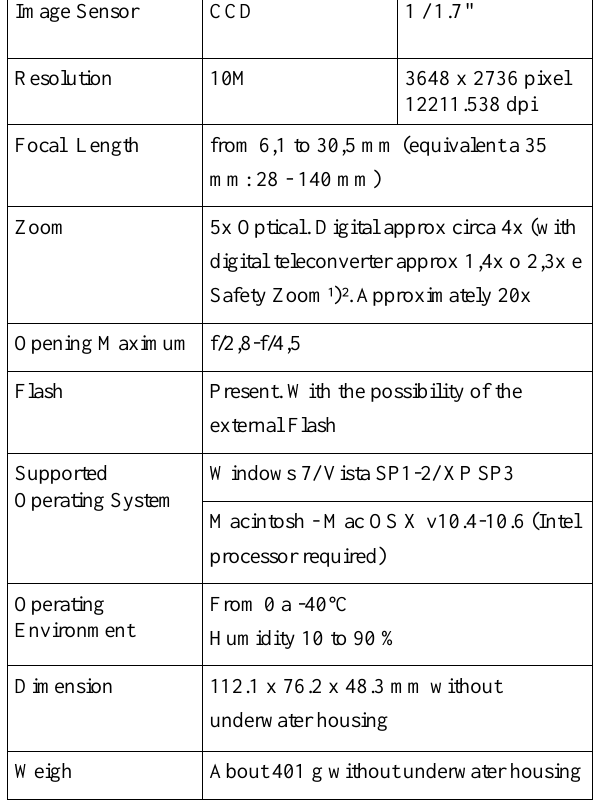
Table 1. Main characteristics of Canon camera